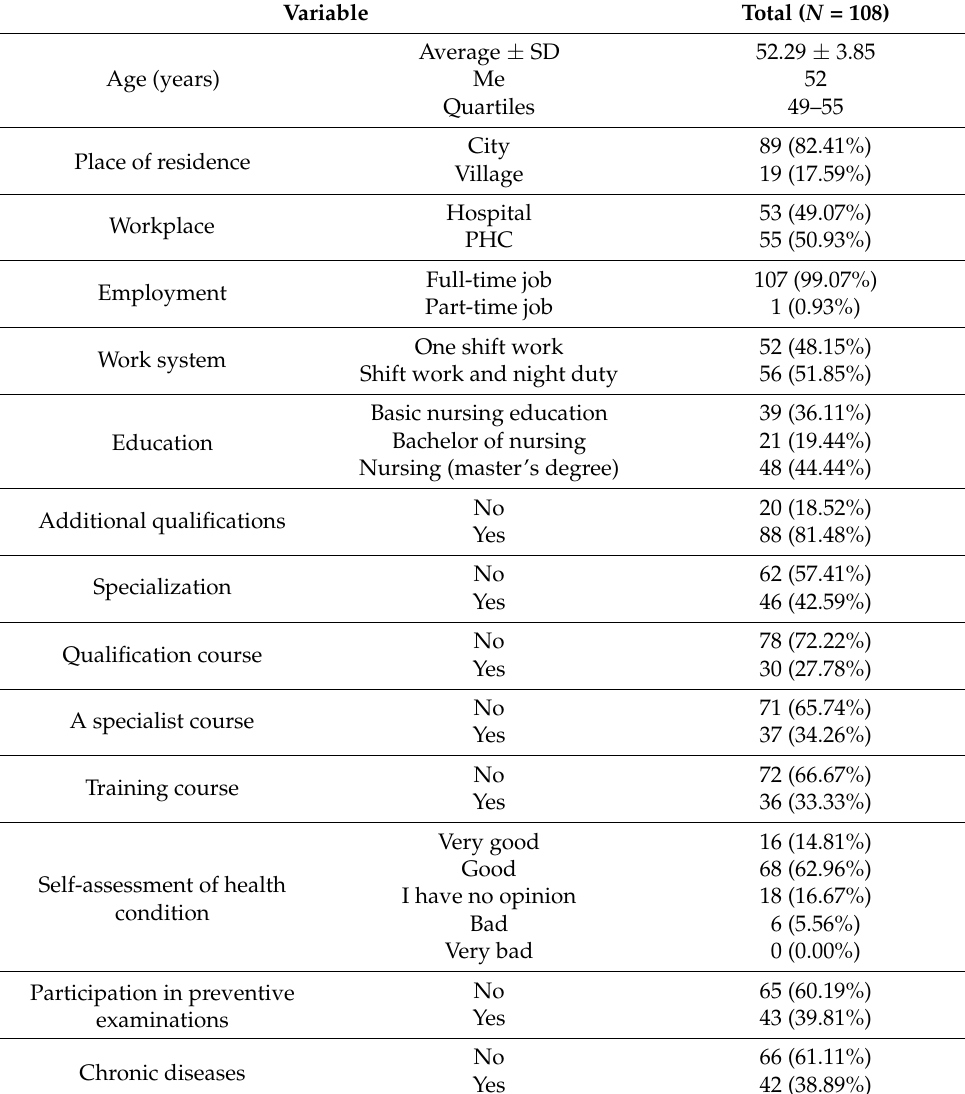
Table 1. Socio-demographic characteristic of the study